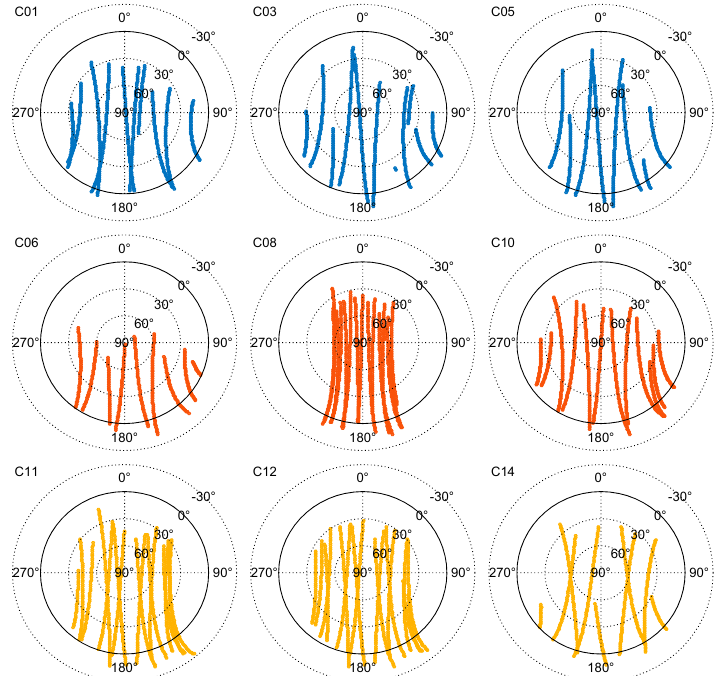
Figure 6. Sky view of BeiDou satellites in antenna reference frame observed by FY-3C GNOS receiver with 30s sampling interval on 14 July 2017. Top with blue points, middle with red points, and bottom with yellow points in the figure are prepared for GEO (C01, C03, C05), IGSO (C06, C08, C10), and MEO (C11, C12, C14), respectively.